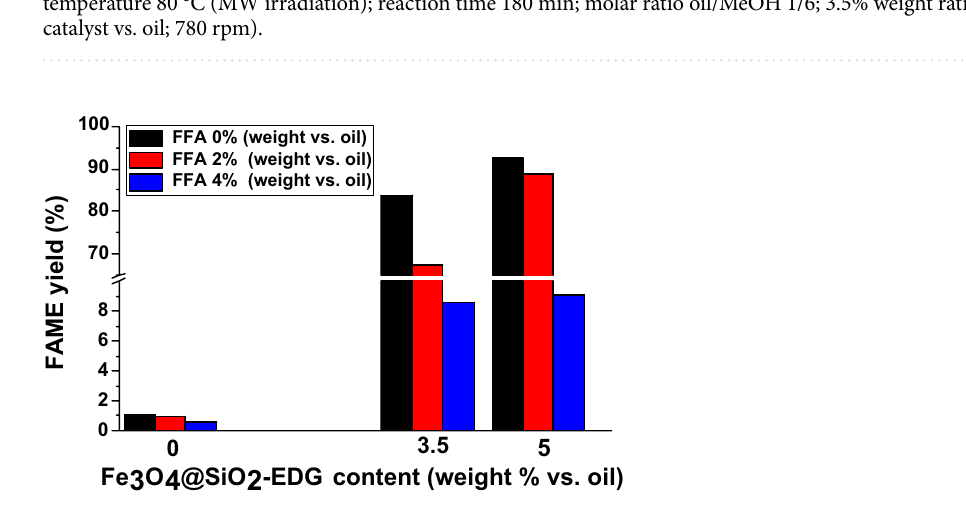
Figure 10. FAME yield depending on the Fe 3 O 4 @SiO 2 catalyst content (wt% vs oil) and FFA content in the oil (activated catalyst; temperature 80 °C (MW irradiation); reaction time 180 min; molar ratio oil/MeOH 1/6; 780